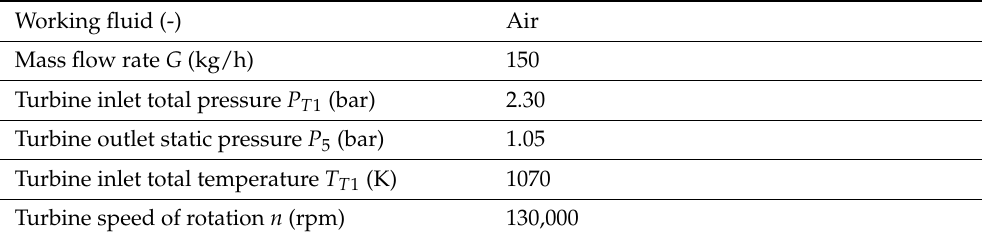
Table 1. Conditions and parameters adopted for the design of the radial exhaust gas turbine. Working fluid (-)